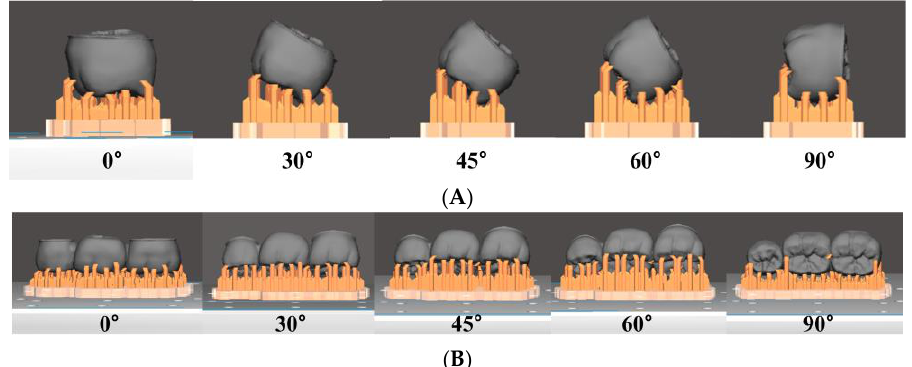
Figure 2. The prosthesis design of five build orientations (0°, 30°, 45°, 60°, and 90°). The supporting structure was connected perpendicular to the occlusal surface of the prosthesis in the 0° build orientation, and was connected perpendicular to the lingual surface of the prosthesis in the 90° build orientation. ( A ) Distal view and ( B ) buccal view of the designed prosthesis.